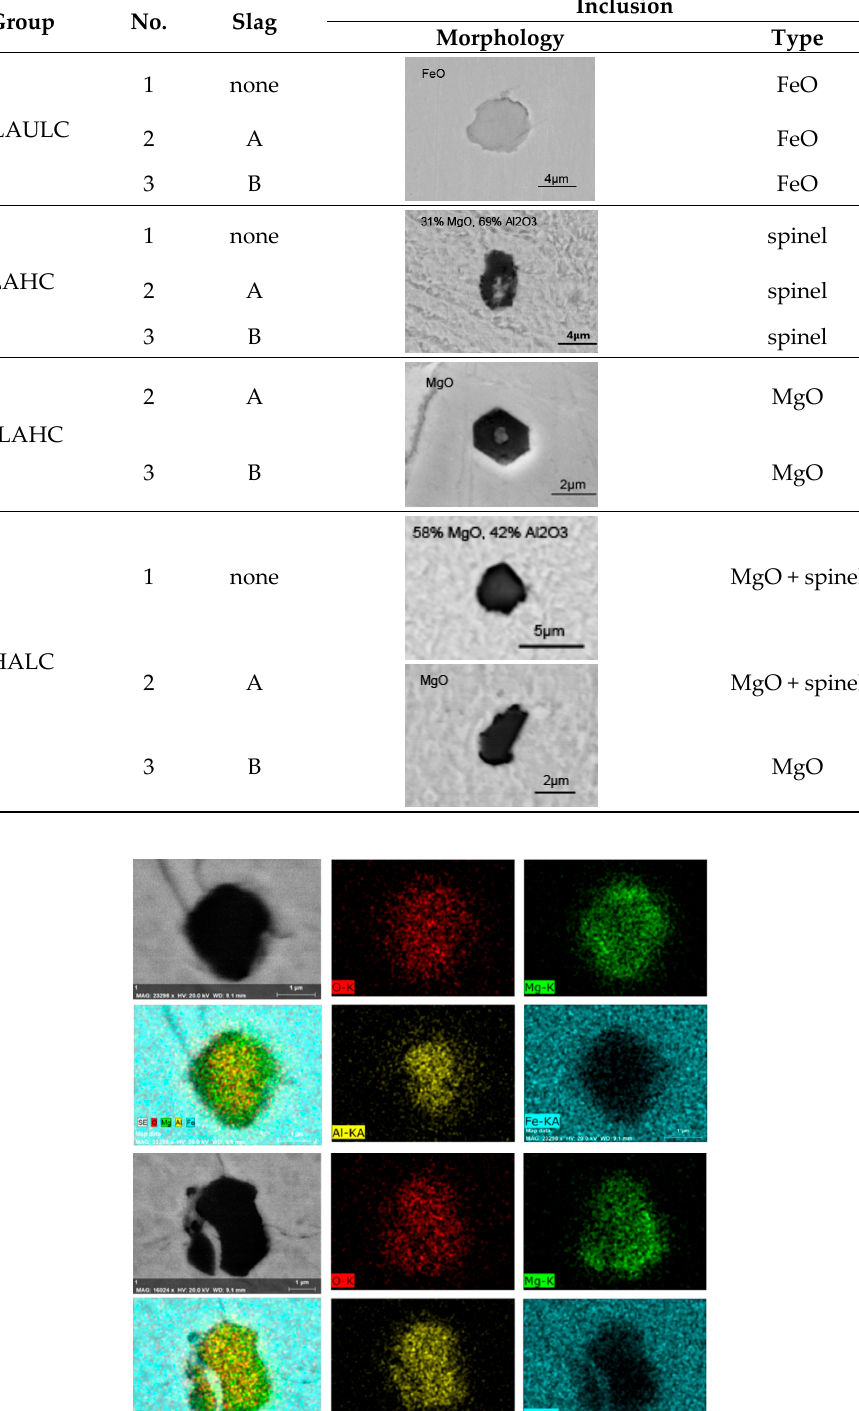
Figure 3. Average MgO content in inclusions after quasi-equilibrium experiments. 5. Formation Mechanism of MgO-Containing Inclusions According to the experimental results, a simple formation mechanism of MgO-containing inclusions in the steel with different compositions in MgO crucible is proposed, as illustrated in Figure 4. In ultra-low Al ultra-low C steel ([Al] < 0.0010%, C < 0.0025%, corresponding to the group of ULAULC), the molten steel and the refractory are substantially unreactive. In high C steel (C > 0.5%, corresponding to the groups of LAHC and ULAHC), at the interface of crucible-steel or slag- steel, Reaction (1) will take place, that MgO will be reduced by [C] to generate [Mg] and CO gas, which is consistent with the phenomenon that many gas holes existed on the surface of steel samples of group LAHC and ULAHC. When a certain amount of [Al] is contained in the steel (approximately > 0.0020%, corresponding to the groups of LAHC and HALC in the current work), Reaction (2) may also happen, that MgO will be reduced by [Al]. When the generated [Mg] diffuses into the melt, it will react with the residual Al 2 O 3 or [Al] to form MgO-Al 2 O 3 type spinel in the LAHC and HALC steels, shown as Reaction (3) or (4). In the high C steel with ultra-low Al content ([Al] < 0.0010%, corresponding to the group of ULAHC), [Mg] and [O] will react with each other directly to generate pure MgO in the melt, shown as Reaction (5). In the high Al low C steel ([Al] > 0.01%, C < 0.006%,